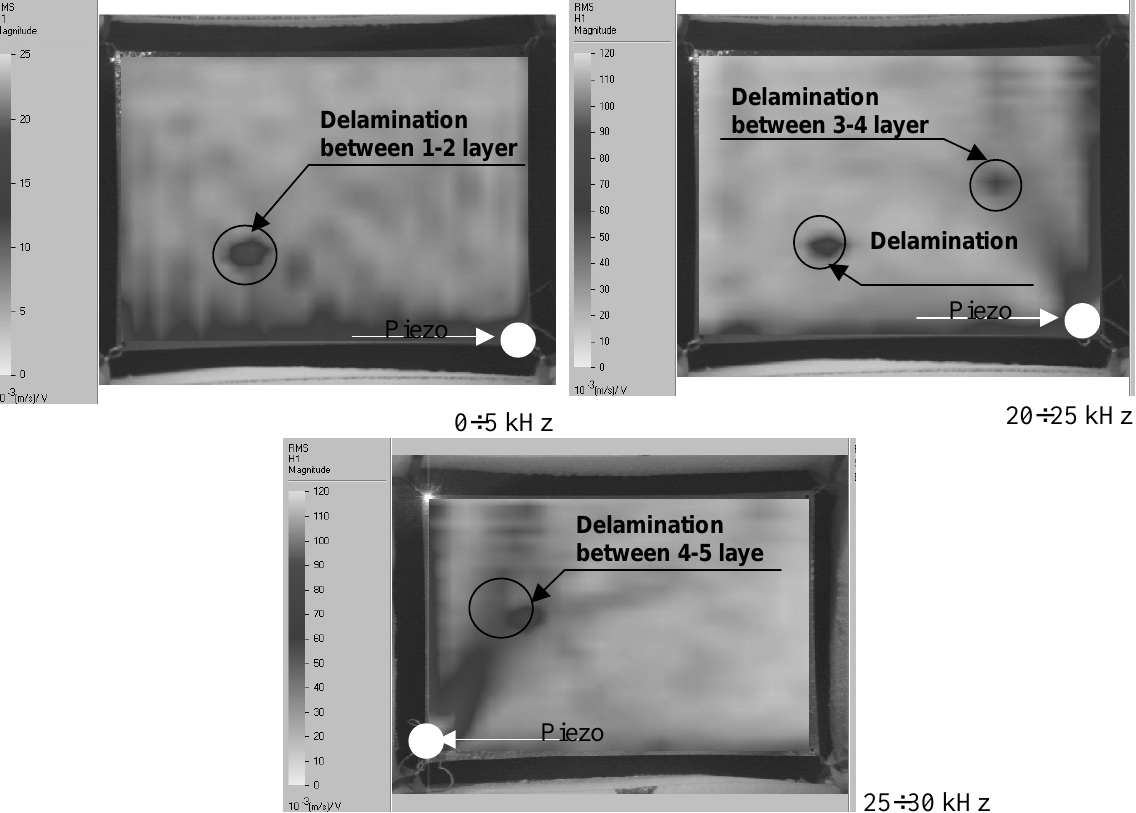
Fig. 12. RMS maps of FRFs at different frequency bands measured on the composite